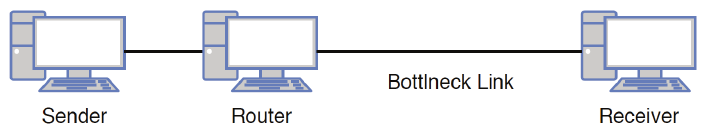
Figure 8. Schematic of the simple topology used in the